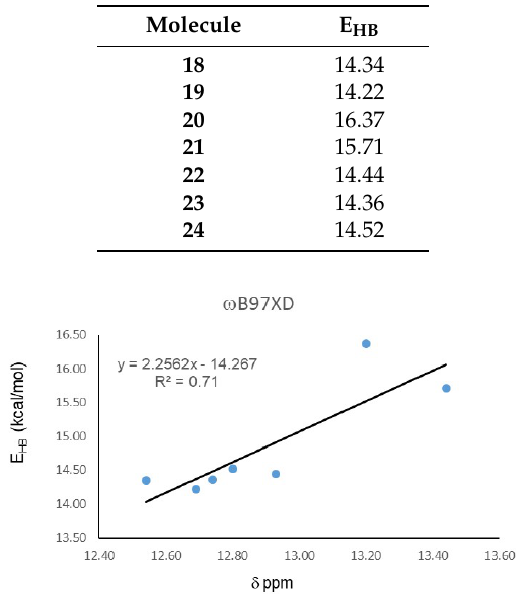
Figure 2. Correlation between Hydrogen bond energy (E HB ) and 1 H-NMR chemical shifts ( δ ).